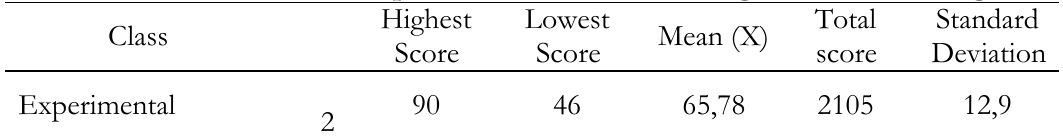
TABLE 4.9 Post-test scores of experiment class at Senior High School 3 Padang Panjang